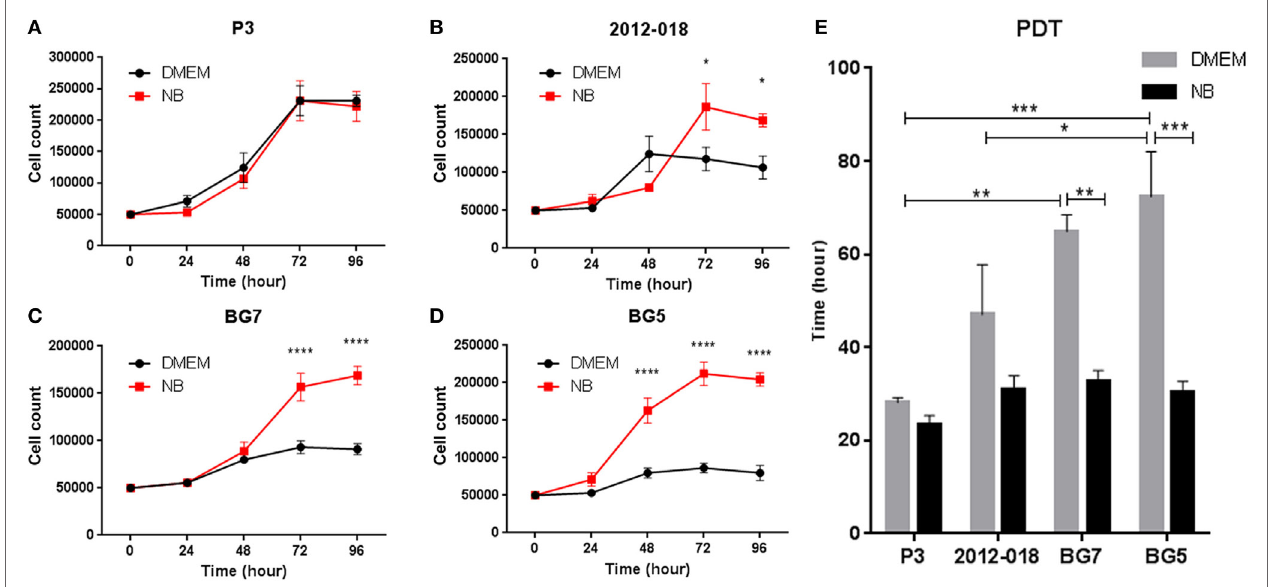
FigUre 3 | Differentiated glioblastoma (GBM) cells have slower proliferation rates and population doubling time (PDT). Growth curves showing number of (a) P3, (B) 2012-018, (c) BG7, and (D) BG5 GBM cells after 0, 24, 48, 72, and 96 h cultured in Dulbecco’s modified eagle medium (DMEM) (black) or NB (red). (e) PDT of GBM cells cultured in DMEM (gray) or NB (black). Data represent mean ± SEM of n = 3 independent experiments per GBM patient-derived cell line. Two-way ANOVA, Bonferroni’s multiple comparison test, * P < 0.05; ** P < 0.01; *** P < 0.001; **** P <